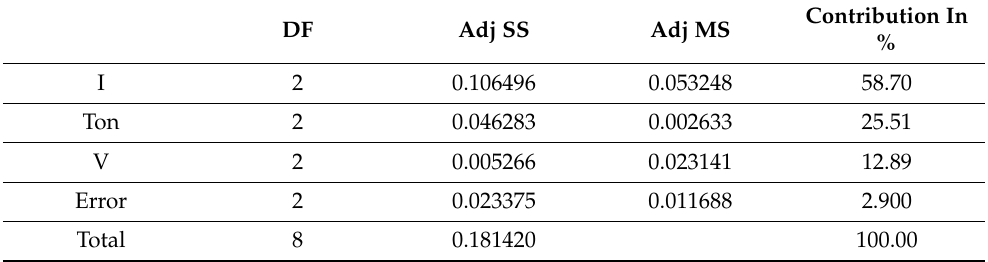
Table 7. Analysis of variance for sample B.